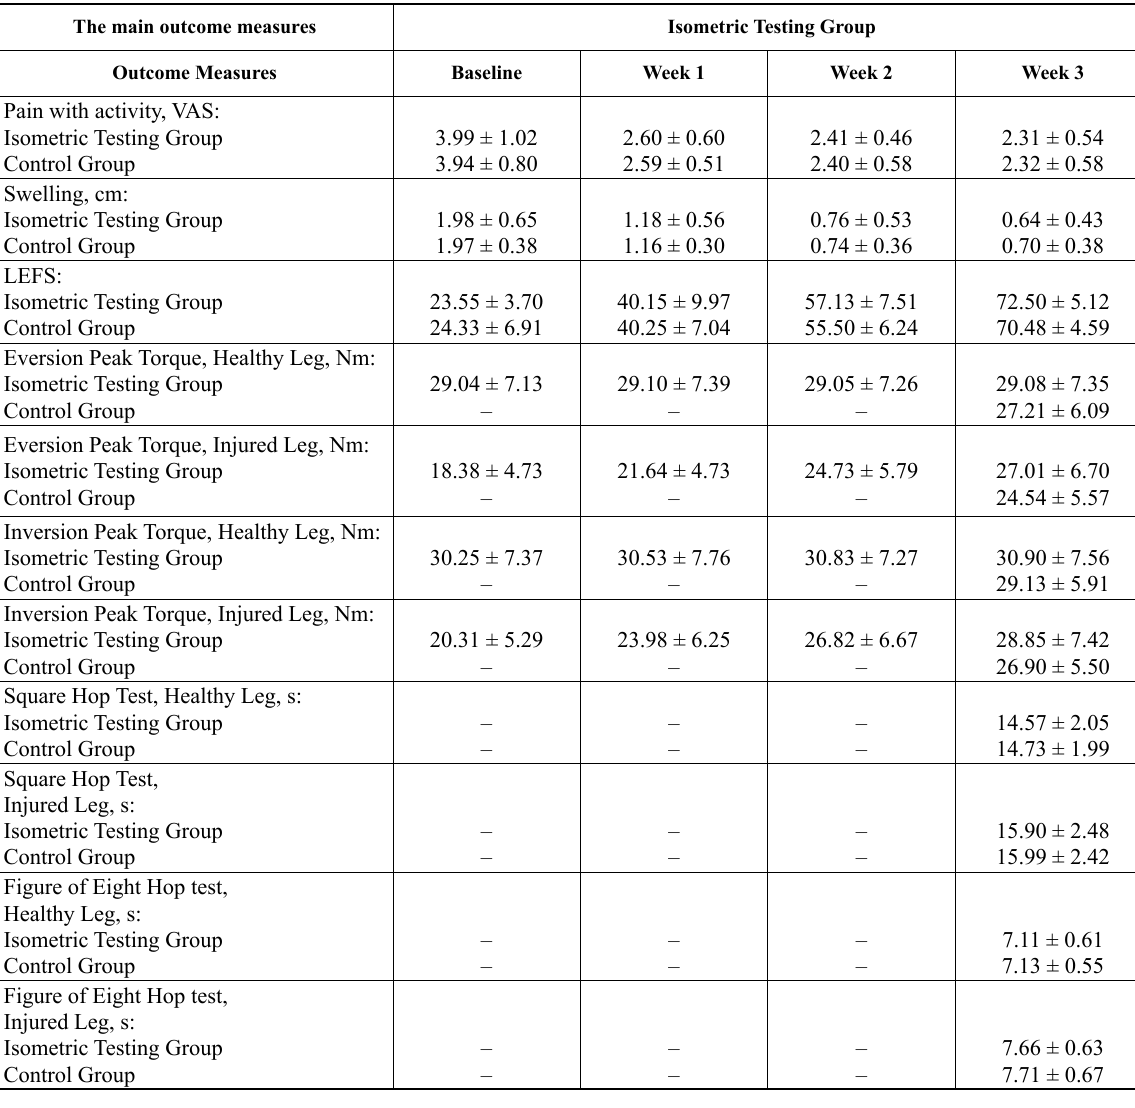
Table 2. Summary of the main outcome measures in both groups, all data presented as means ± standard deviation The main outcome measures